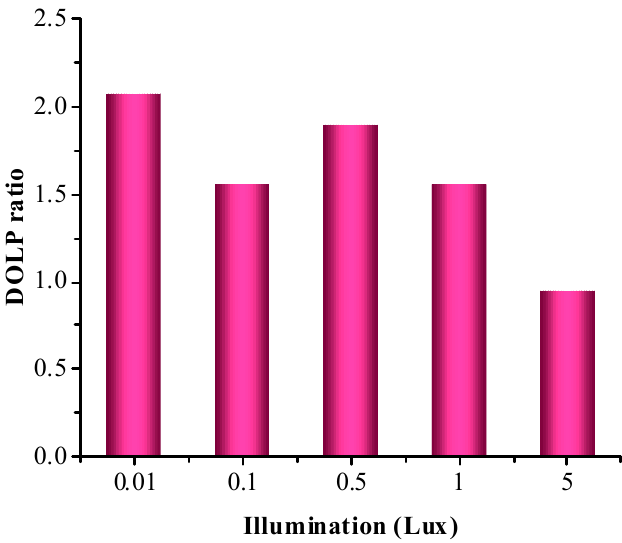
Figure 8. Histogram of the DoLP with different illuminations.